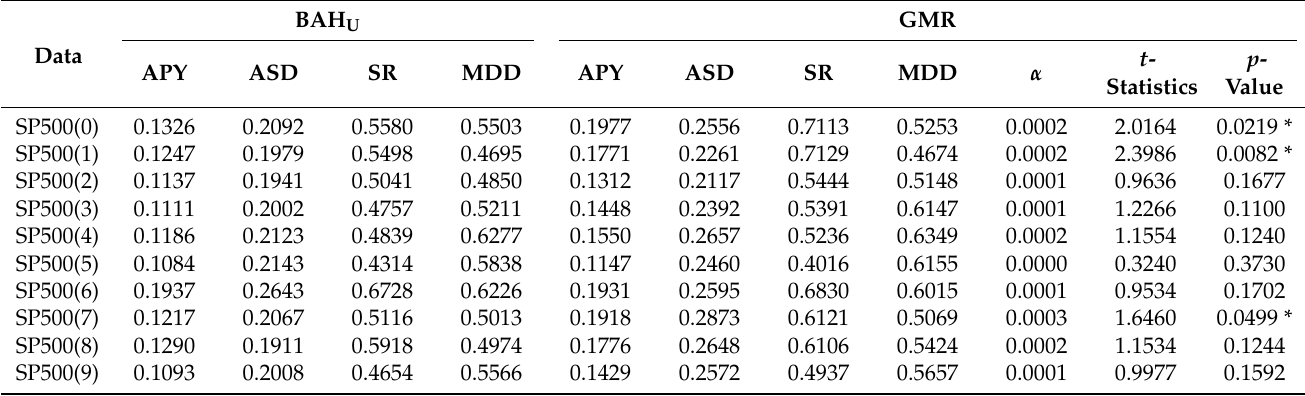
Table 5. APY, ASD, SR, MDD, and α , t -statistic, and p -value of GMR on the S&P 500 datasets. The